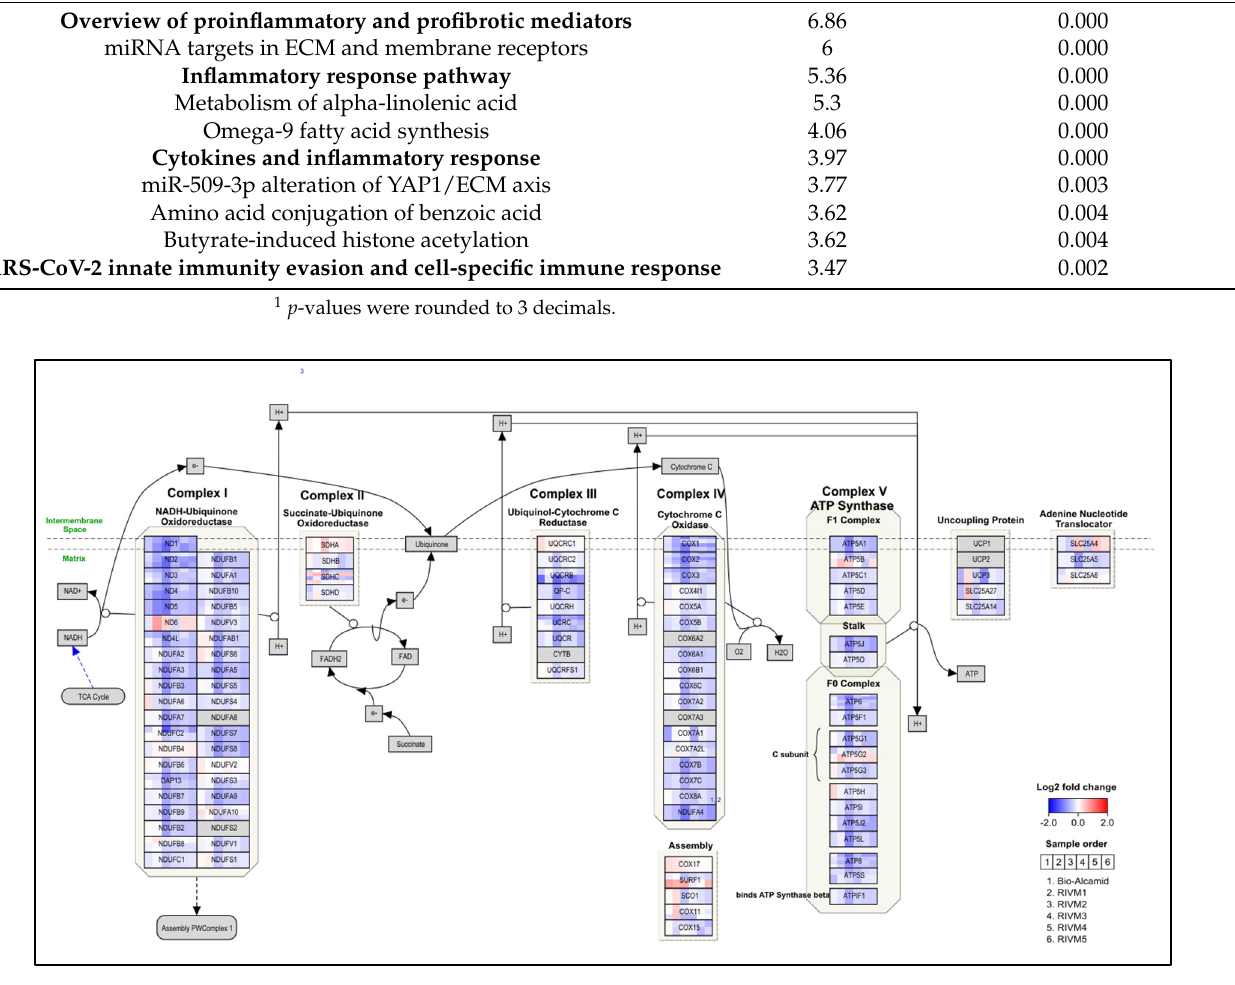
Figure 3. Visualization of gene expression changes for Phenion ® Full-Thickness Skin model exposed to Bio-Alcamid ® and RIVM preparations on the Electron transport chain: OXPHOS system in mito- chondria